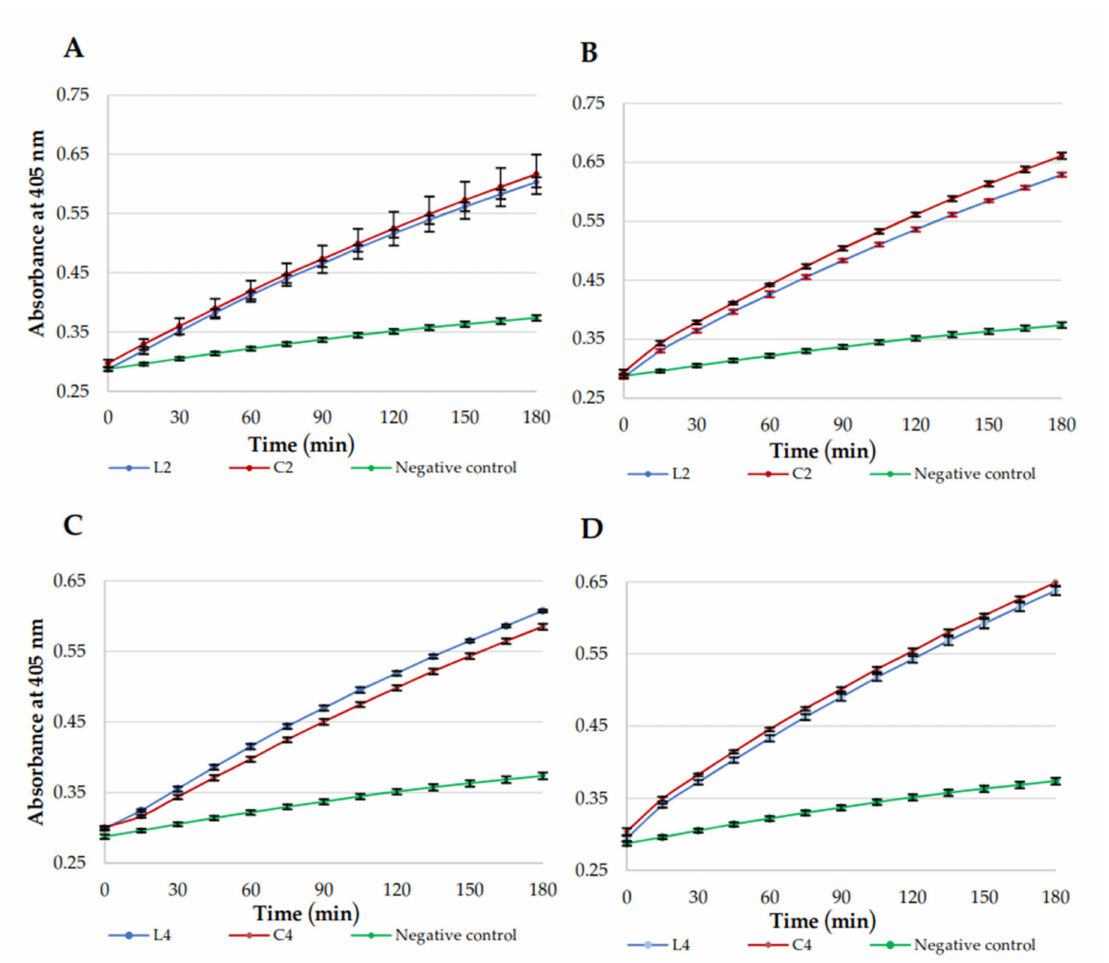
Figure 4. Outer membrane (OM) permeabilization kinetics. ( A ) L2 and C2 , 4 µ g / mL; ( B ) L2 and C2 , 8 µ g / mL; ( C ) L4 and C4 , 4 µ g / mL; and ( D ) L4 and C4 , 8 µ g /